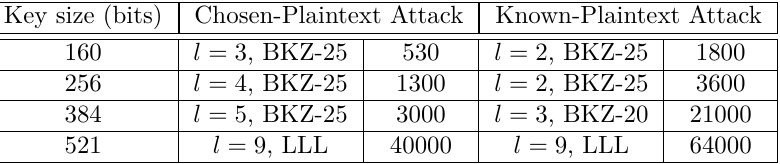
Figure 1: Performance of LLL reduction algorithm when solving the HNP for a 521 bit modulus. Reduction fails for f < 1 and succeeds for f > 1 . 3, which aligns with expectations of the estimate of the number of inequalities needed. Table 2: Approximate parameters for the minimum signatures required. These values performed the best of the combinations that were tested, and they gave above a 90% success rate. Under these parameters, the reduction step reliably finished in under five minutes. Here, BKZ-25 is shorthand for BKZ reduction algorithm with a block size of 25. Chosen-Plaintext